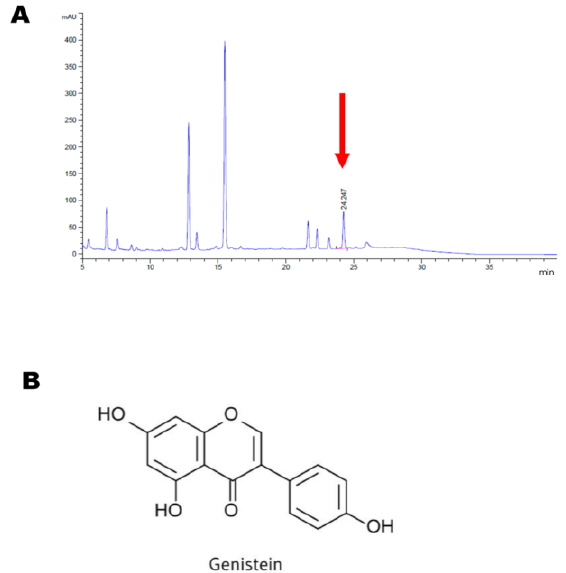
Figure 6. The HPLC analysis of the standard material to GM. Phytochemical analysis was performed by HPLC as described in the materials and methods section. ( A ) GE was utilized as an authentic standard (arrows), and the concentration of GE in GM was calculated. ( B ) Chemical structure of GE.